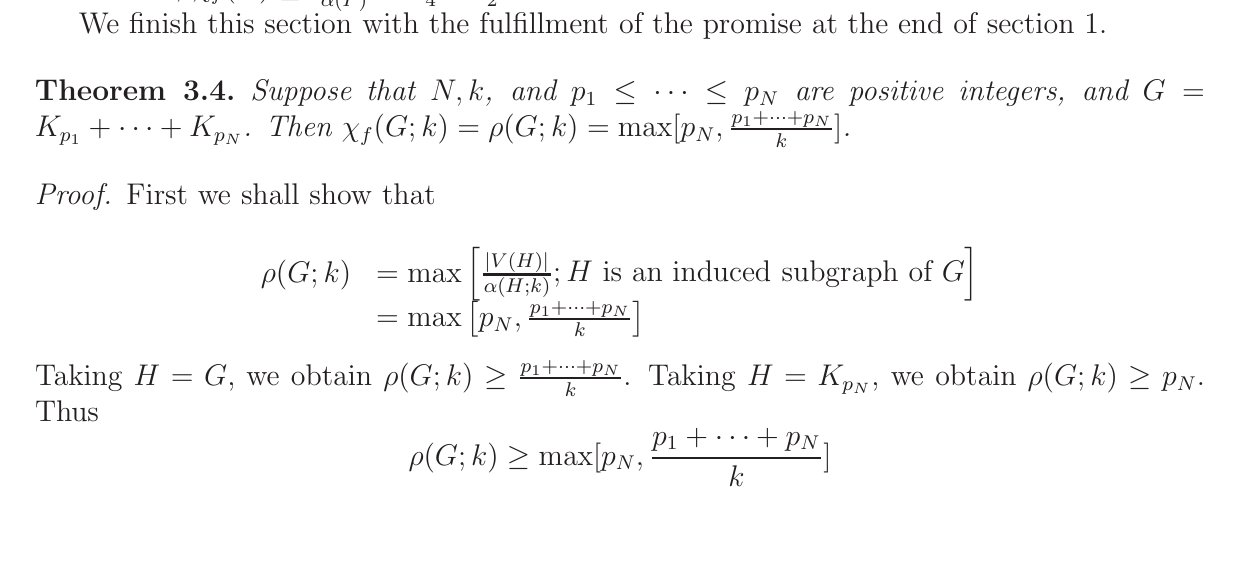
Figure 2: A scheduling function on P with all meetings contained in (0 , 5 assignment a union of 1 or 2 open